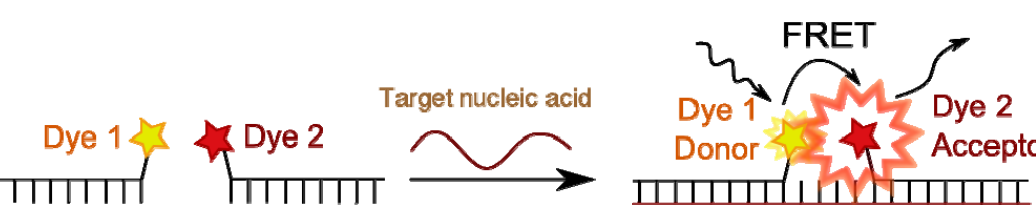
Figure 9. Fluorescence Resonance Energy Transfer